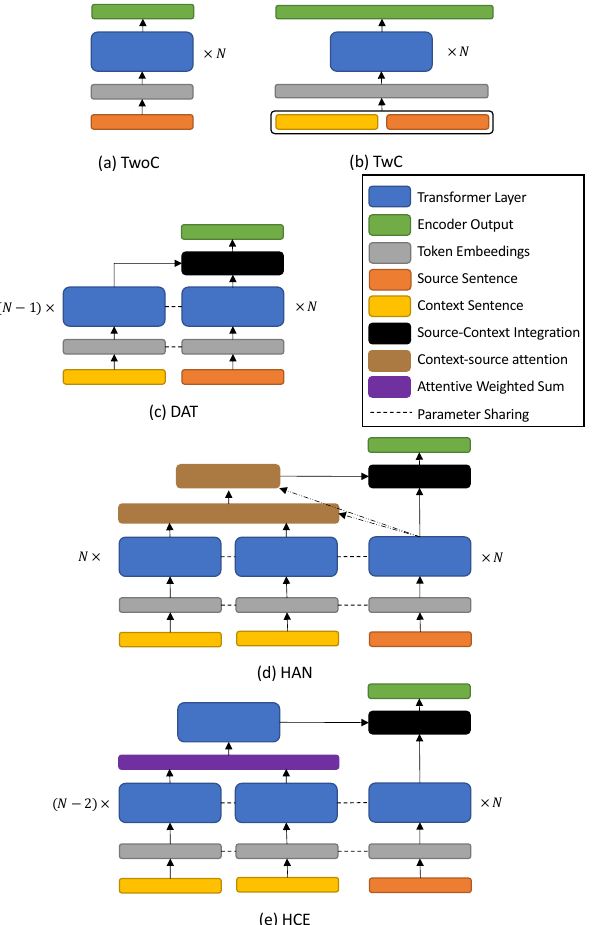
Figure 3. The structure of compared contextual encoders; ( a ) TwoC ( b ) TwC ( c ) DAT ( d ) HAN and ( e )